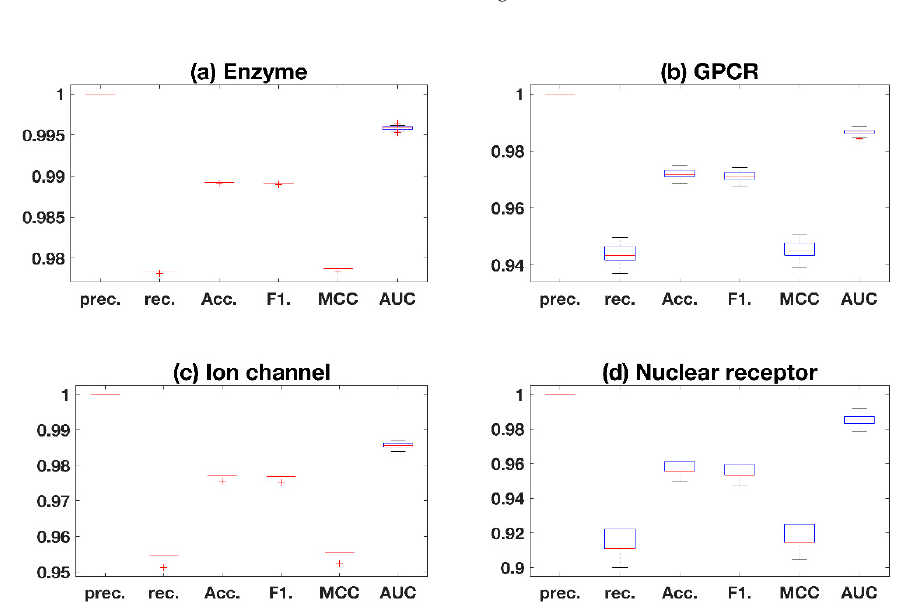
Figure1. Distributionofresultsinbenchmarkdatasets. Prec., rec., acc., F1. andMCCareabbreviationsof Figure 1. Distribution of results in benchmark datasets. Prec., rec., acc., F1. and MCC are Precision, Recall, Accuracy, F1-scores and Matthews Correlation Coe ffi cient, respectively. AUC indicates abbreviations of Precision, Recall, Accuracy, F1-scores and Matthews Correlation Coefficient, the area under respectively. AUC indicates the area under ROC-curve.